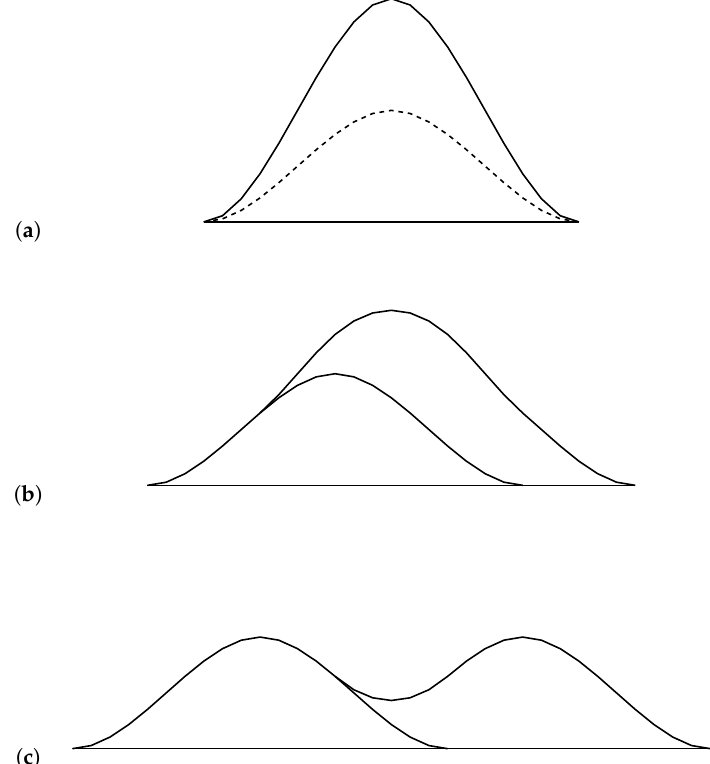
Figure 4. Dividing and merging parcels. ( a ) A single parcel comprising two water mass elements. ( b , c ) The parcel divides into two smaller parcels each comprising one water mass element, which then move independently. Viewing the panels in reverse order illustrates the merging